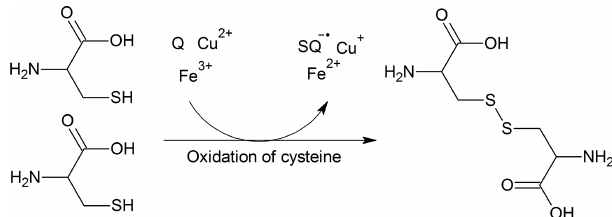
Figure 1. Oxidation of CSH through reaction with quinones (Q) and transition metals (Fe 3 + , Cu 2 + ) and subsequent formation of CSSC, semi-quinones (SQ −· ), and reduced transition metals (Fe 2 + , Cu + ).